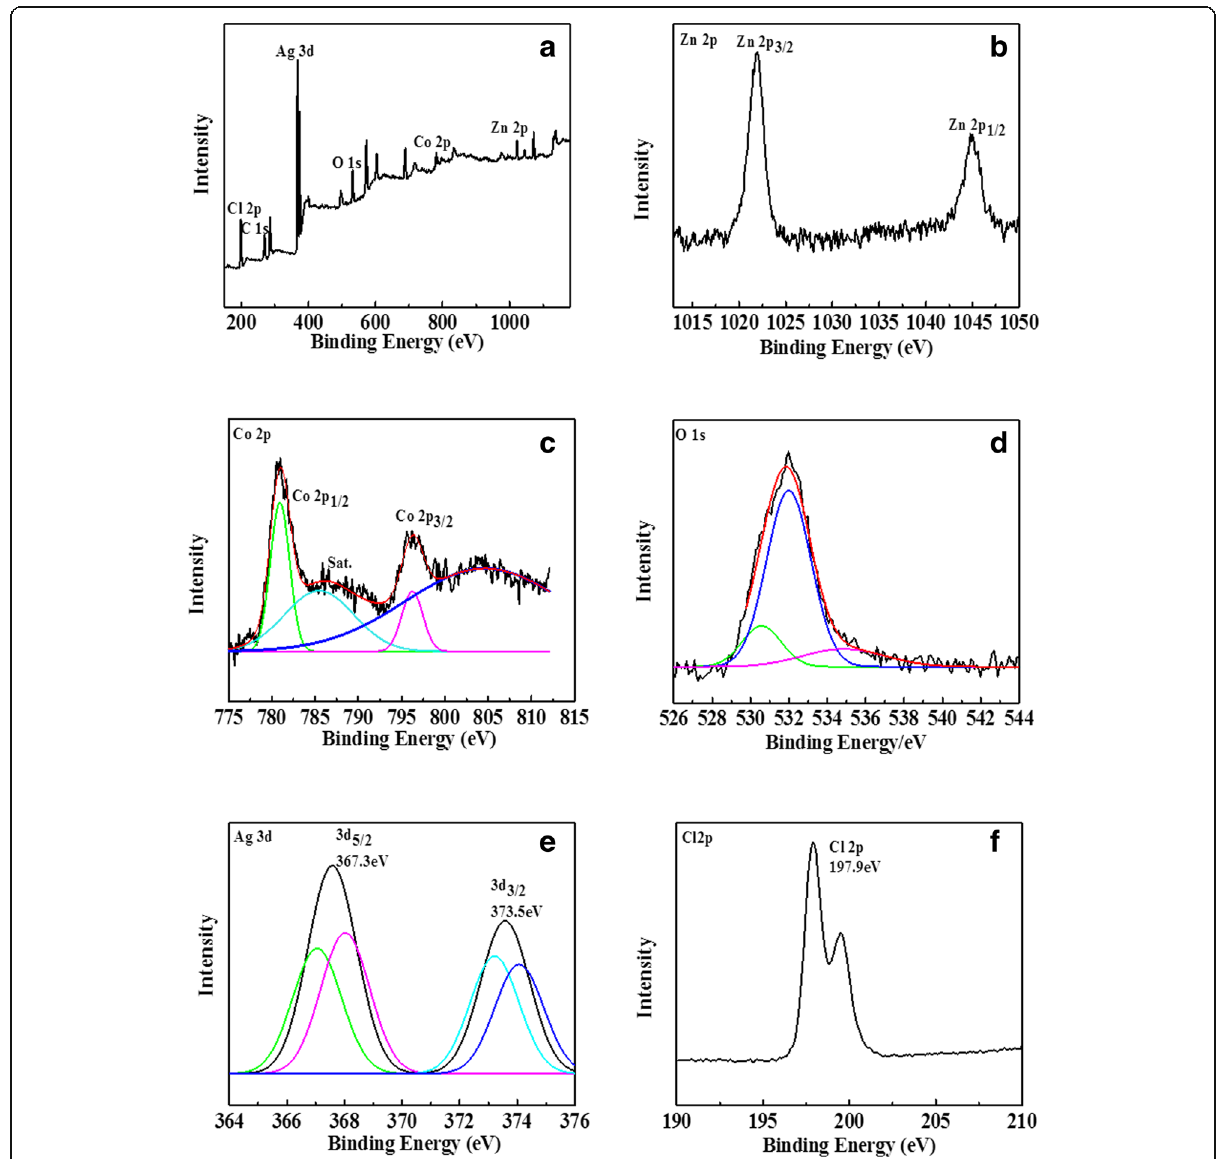
Fig. 3 XPS spectrum of Ag@AgCl/ZnCo 2 O 4 : a survey scan, b Zn 2p, c Co 2p, d O 1 s, e Ag 3d, and f Cl